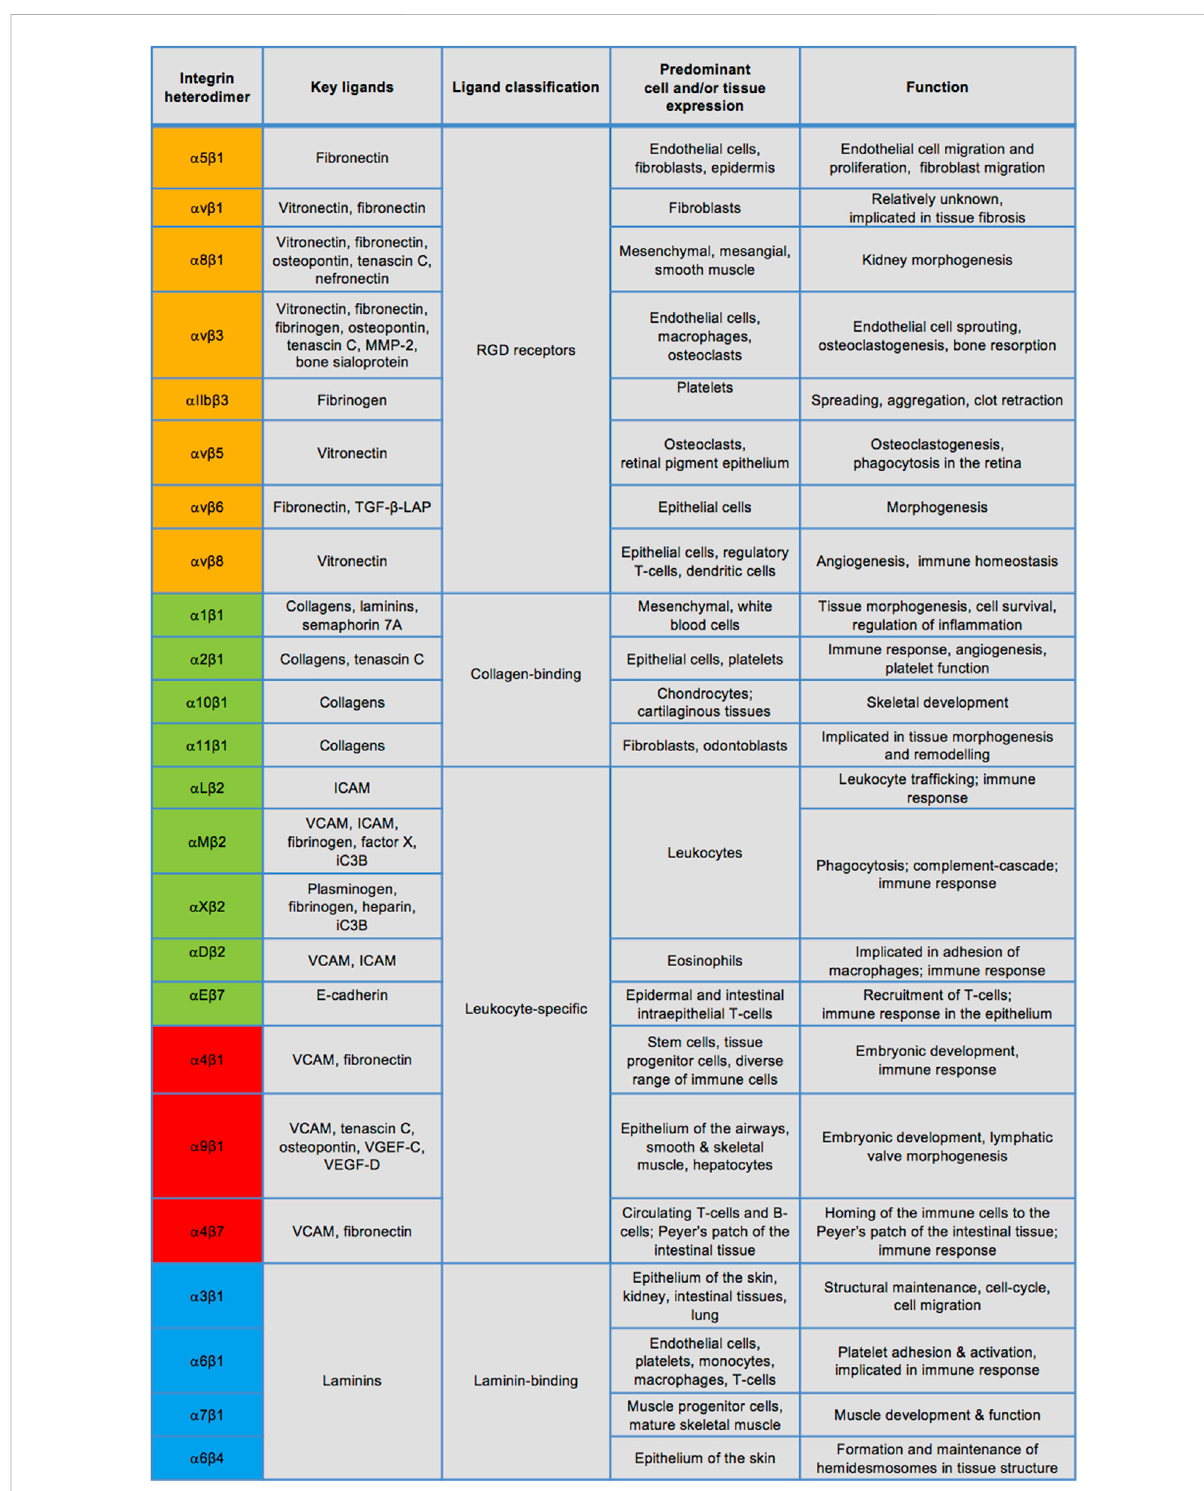
FIGURE 3 Known integrin heterodimers and their ligands, expression, and physiological roles. Integrins in the orange coloured rows have an α subunit evolutionarily related to PS2 proteins of Drosophila , those in the green coloured rows share an α subunit with an α I domain. The blue rows indicate integrinscontainingan α subunitrelatedtoPS1 Drosophila proteinsandmanyoftheseintegrinsrecognisetheECMligandscontainingtheRGDmotif, whereastheredrowsdenoteintegrinsseparatedbytheir α 4/ α 9domains.Thelistofligands,cell/tissueexpressionandfunctionsisnotexclusive. MMP-2: matrix metalloprotease-2, TGF- β -LAP: transforming growth factor- β -latency-associated peptide, ICAM: intracellular adhesion molecule, VCAM: vascular cell adhesion